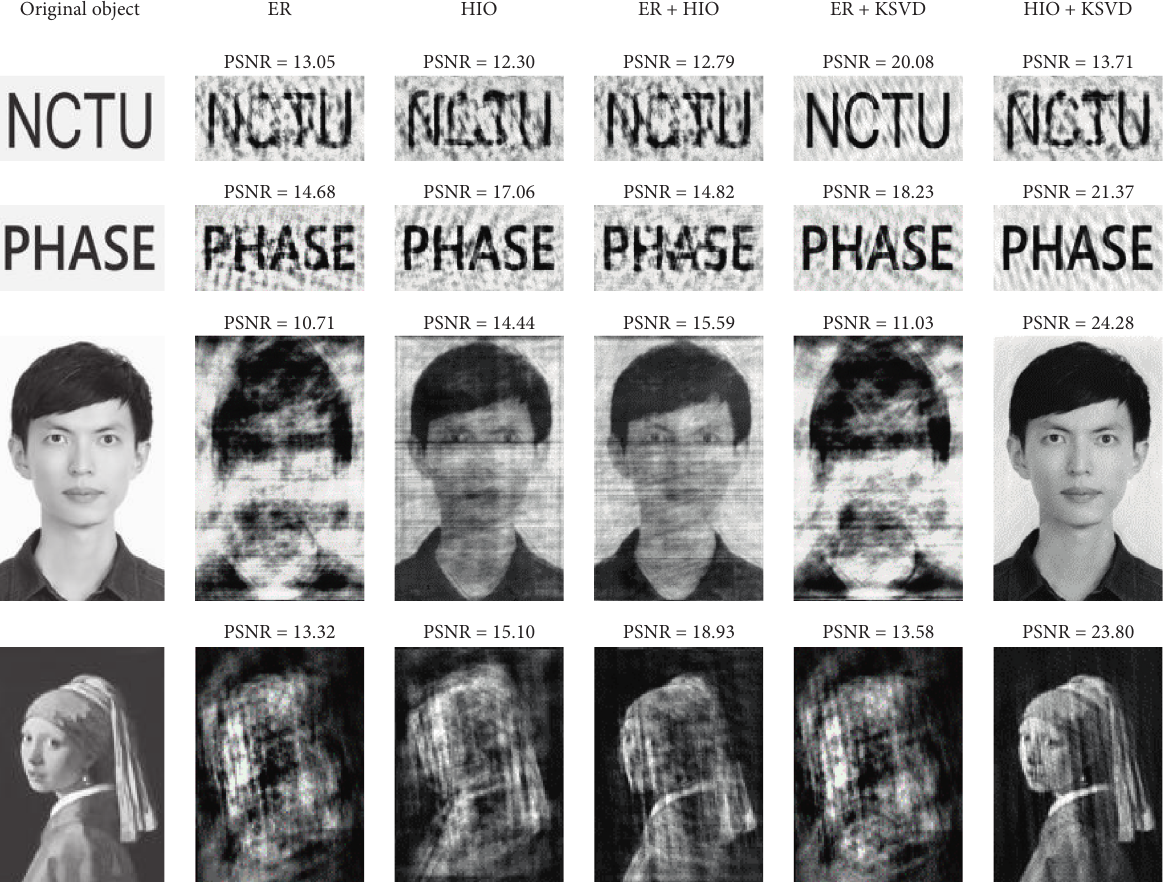
Figure 10: Reconstruction results from the noisy diffraction intensity ( R Fourier phase for fair comparison, and the total number of PR iterations in each algorithm was set to K algorithm, ER and HIO alternatively execute 150 iterations in each cycle until the maximum number of iterations is achieved. In the ER+KSVD and HIO +KSVD algorithms, KSVD is executed every 100 iterations ( K